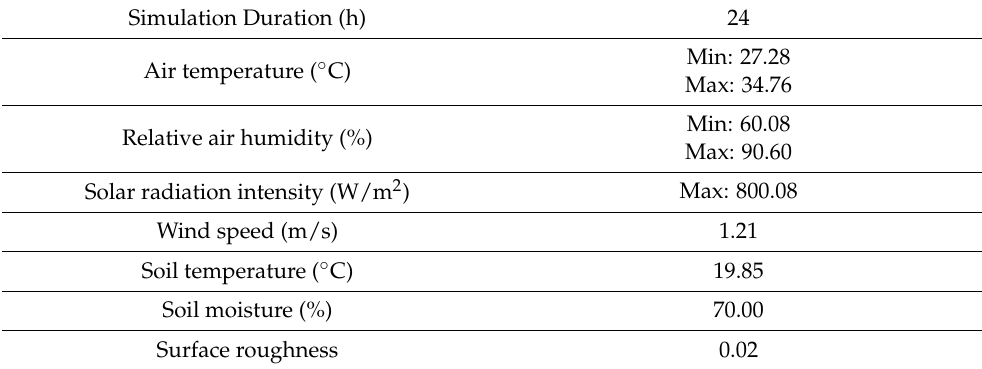
Figure 4. The ENVI ‐ met model of the study area. Figure 4. The ENVI-met model of the study area. Table 3. Boundary parameters setting of the ENVI ‐ met. Table 3. Boundary parameters setting of the